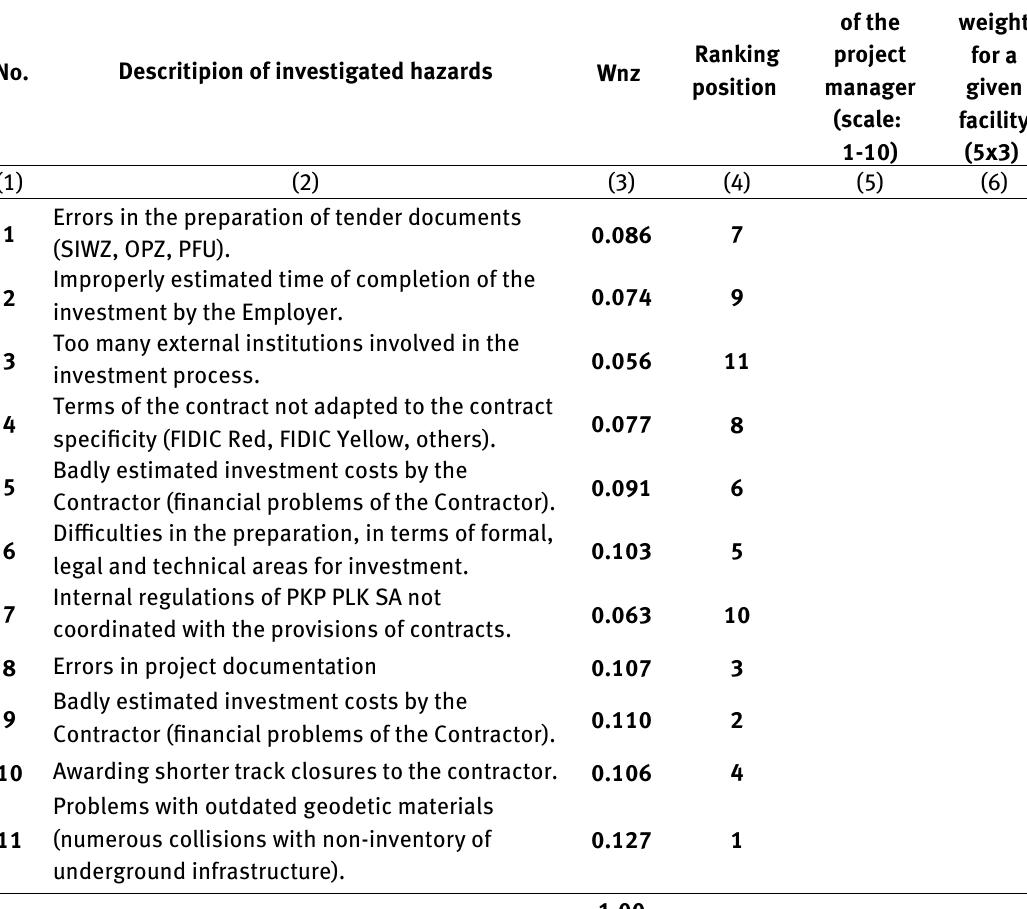
Table 4: Risk matrix with values of normalized weights and their ranking position for K T = K K =0.5 –build stage